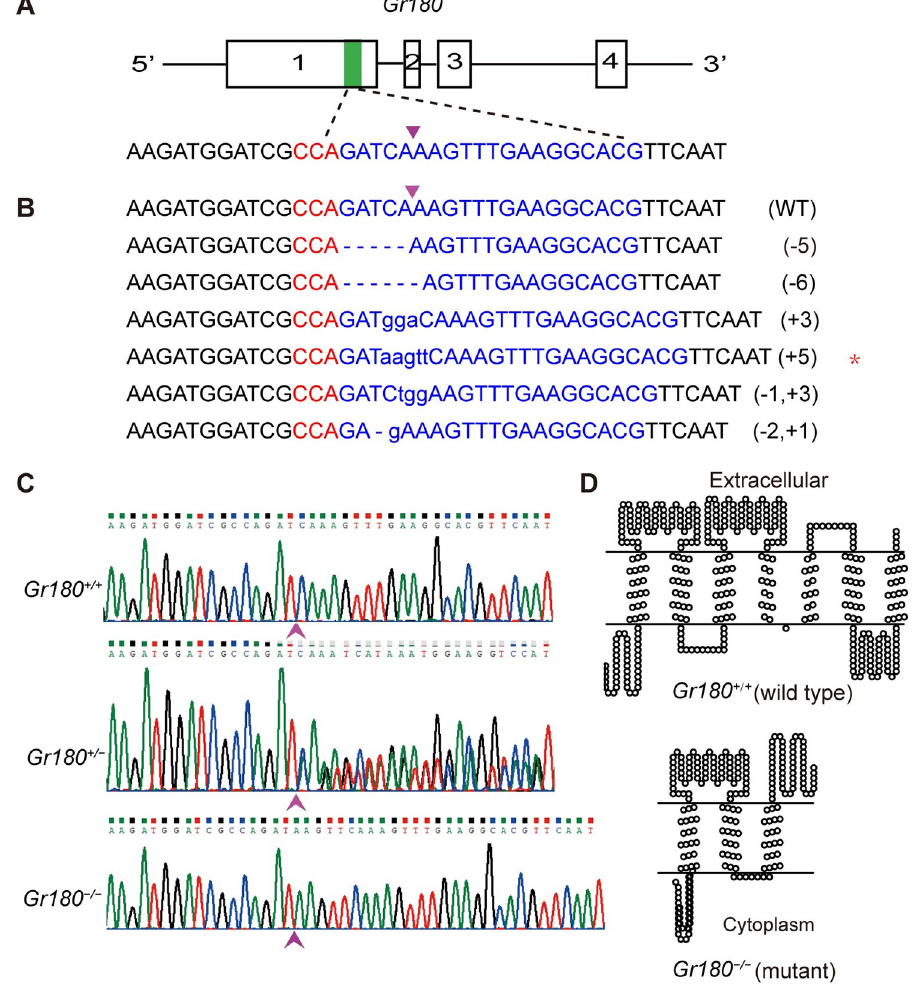
Fig 5. Establishment of Gr180 homozygous mutants of Helicoverpa armigera via CRISPR-Cas9. (A) Genomic structure of Gr180 and designation of sgRNA. Exons are shown as boxes and the lines between two exons indicate the introns. The sgRNA are located on the antisense strand of exon-1 (green box). The sgRNA targeting sequence is shown in blue and the PAM sequence is shown in red. ( B ) Various mutant genotypes of Gr180 identified by sequencing of the G1 adult PCR products. Purple inverted triangle indicates the cleavage site of Cas9 nuclease. Dashes indicate the deleted bases; lowercase letters are the inserted bases. The numbers of inserted or deleted bases are displayed at the right of each allele (+ insertion;–deletion). Red asterisks indicate the selected genotype to establish the homozygous mutant strain. ( C ) Representative chromatograms of direct sequencing of the PCR products obtained from wild types ( Gr180 +/+ , upper graph), heterozygous mutants ( Gr180 +/− , middle graph), and homozygous mutants ( Gr180 −/− , lower graph). The start site of overlapping peaks is marked by a purple arrow. ( D ) Secondary structure prediction of wild type and truncated Gr180 protein. TOPCONS (topcons.net) models were used to predict secondary structure, and TOPO2 software (http://www.sacs.ucsf.edu/TOPO2/) was used to construct the images. In WT, the Gr180 protein consists of seven transmembrane domains, the truncated protein consists of three transmembrane domains in the mutants. of the WT larvae (Fig 7A–7C). The larvae of WT and Gr180 −/− barely fed on leaf discs treated with 10 − 3 M azadirachtin, and there was no significant difference in the feeding deterrence index between WT and Gr180 −/− (Fig 7D). These results indicate that the knockout of Gr180 attenuates the deterrent effect of coumarin, sinigrin, and strychnine on the feeding of H . armi- gera larvae but has no effect on the deterrent effect of azadirachtin.